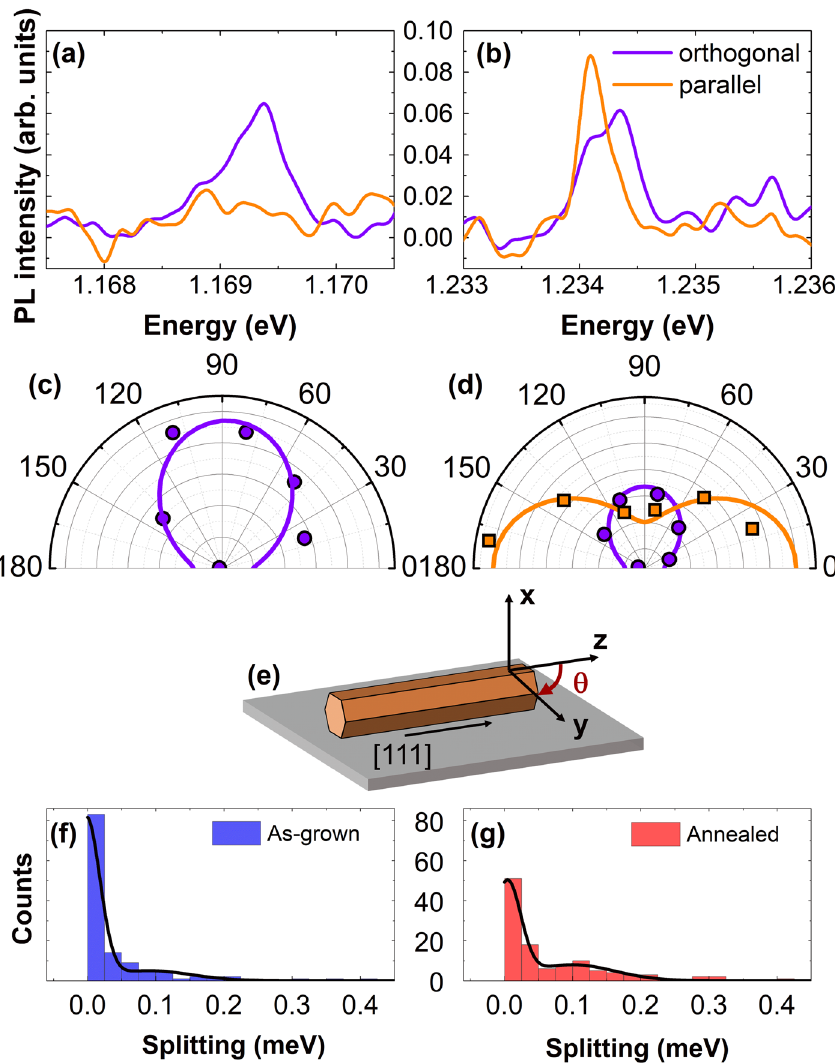
Figure 4. The effect of strain on the QDs. Representative polarization-resolved single QD-like emission lines with the polarization axis orthogonal to the NW axis z ( a ) and with a split pair of orthogonally polarized lines ( b ). ( c ) and ( d ) show the corresponding polar plots of line intensities for the lines shown in (a) and (b), respectively. The circles and squares show intensities of the PL line polarized along y and z axis, respectively, with the axes and polarization detection angle θ as defined in ( e ). ( f ) and ( g ) show distributions of the splitting between the two orthogonally polarized QD-like emission lines in the as-grown and the annealed samples, respectively, collected from 125 QD-like lines for each structure. The solid lines are the fitting curves of the distribution using the Gaussian